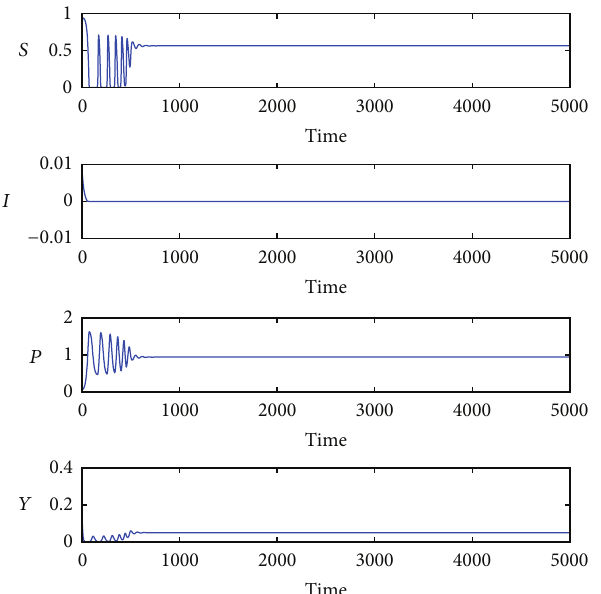
Figure 1: Dynamical responses of model system (20) with the optimal taxation and vaccination 𝜎 𝛿 = 1.0653 and 𝑢 1𝛿 = 0.483 .